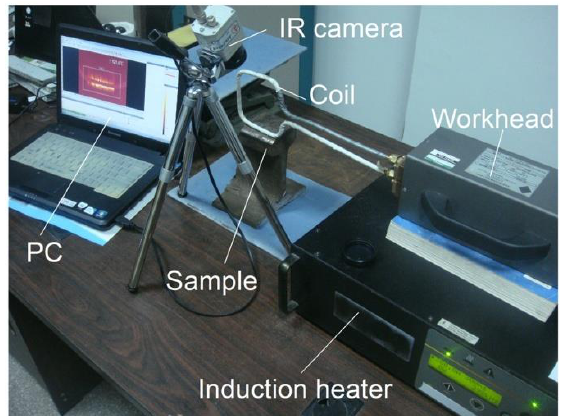
Figure 7. Experimental system of ECPT.